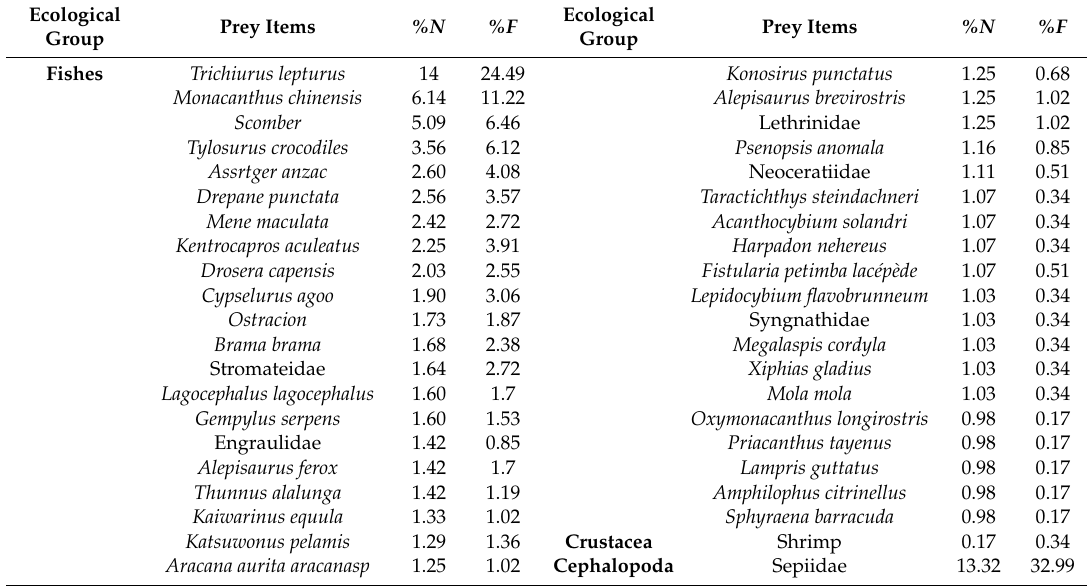
Table 2. The diet composition of Acanthocybium solandri in the Western and Central Pacific Ocean. %N = percentage by number; %F = percentage by frequency of occurrence.